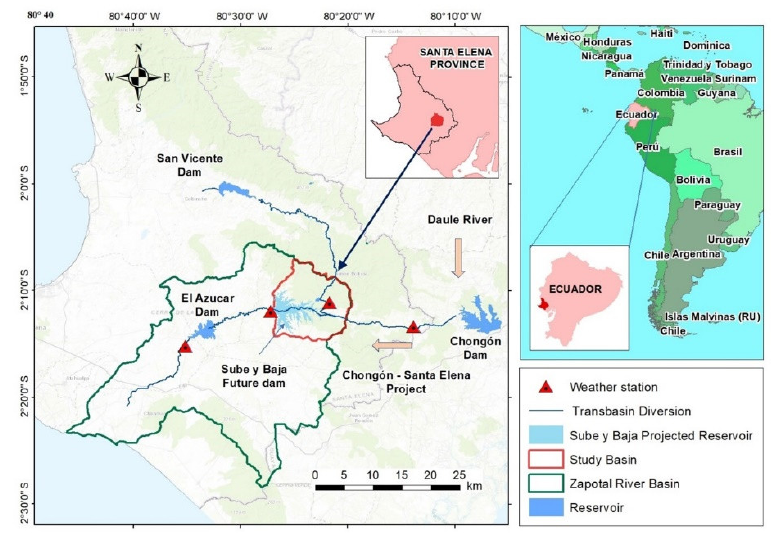
Figure 4. Chongón–Santa Elena transfer system and the Sube y Baja dam. Figure 4. Chong ó n–Santa Elena transfer system and the Sube y Baja